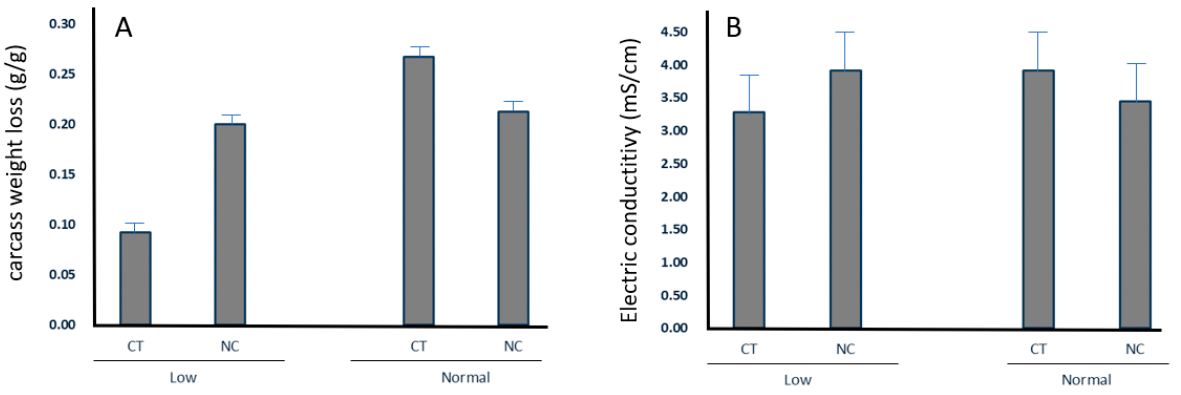
Figure 3. Interaction effect between neonatal care treatment and birth weight on carcass weight loss ( A ) and meat electric conductivity ( B ).